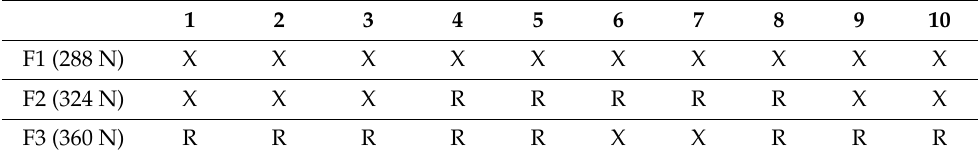
Table 4. Friction sensitivity test results for PBX 2 (R—reaction).